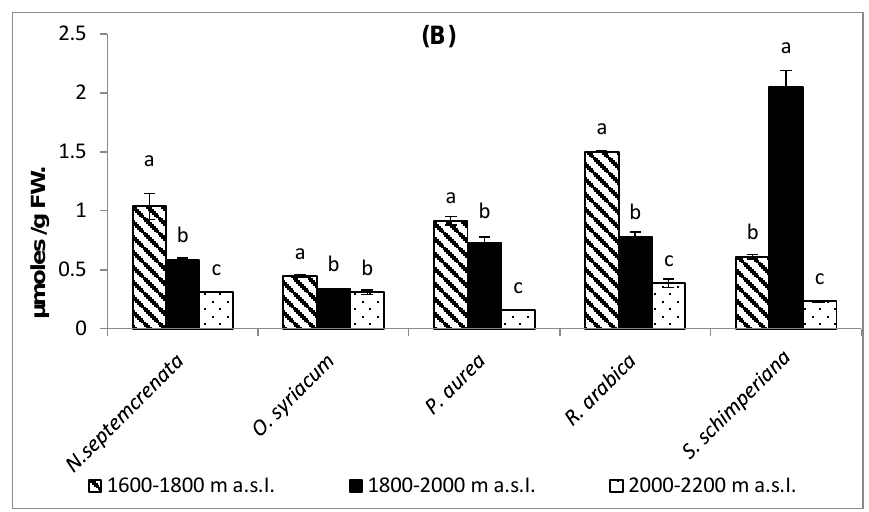
Figure 7. Effect of altitude on the total antioxidant capacity ( A ) and the content of malondialdehyde ( B ). Each value is the mean of three replicates ± SE. Bars with different letters are significantly different at p ≤ 0.05.